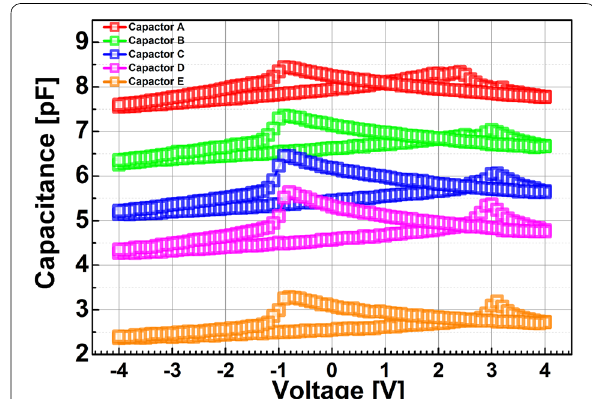
Fig. 1 Measured capacitance vs. voltage applied to the ferroelectric capacitor with a few areas. The area of ferroelectric capacitor A, B, C, D, and E is 50 50 μm 2 , 45 45 μm 2 , 40 40 μm 2 , 30 30 μm 2 , and × × × × 20 20 μm 2 , ×